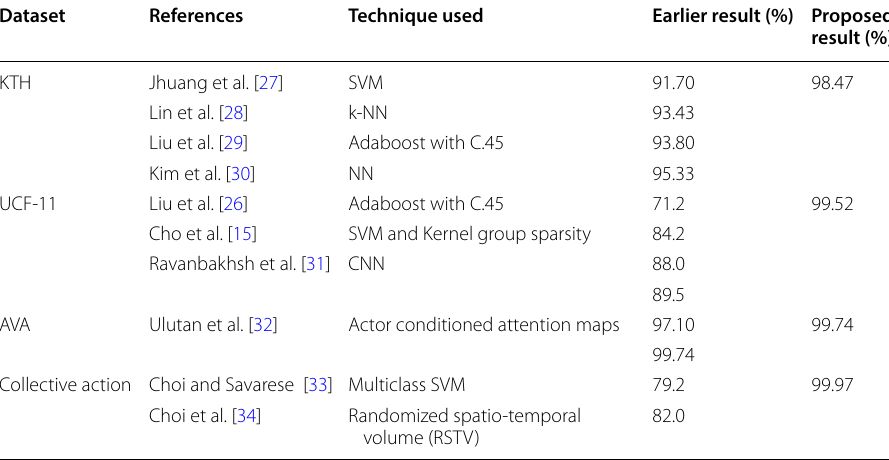
Table 7 Comparison of accuracy on different datasets (KTH, UCF-11, AVA, collective